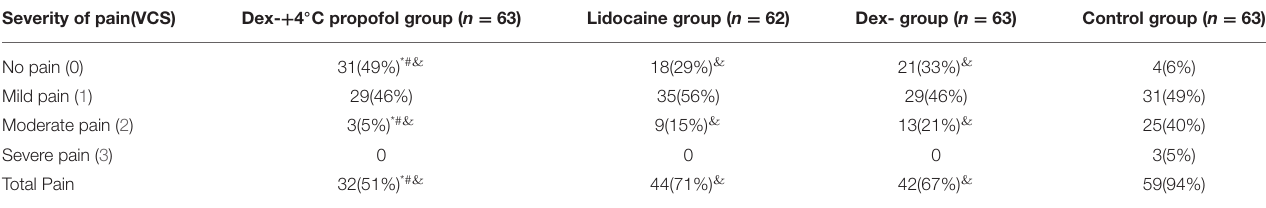
TABLE 2 | Incidence and severity of propofol injection pain ( n = 251). Severity of